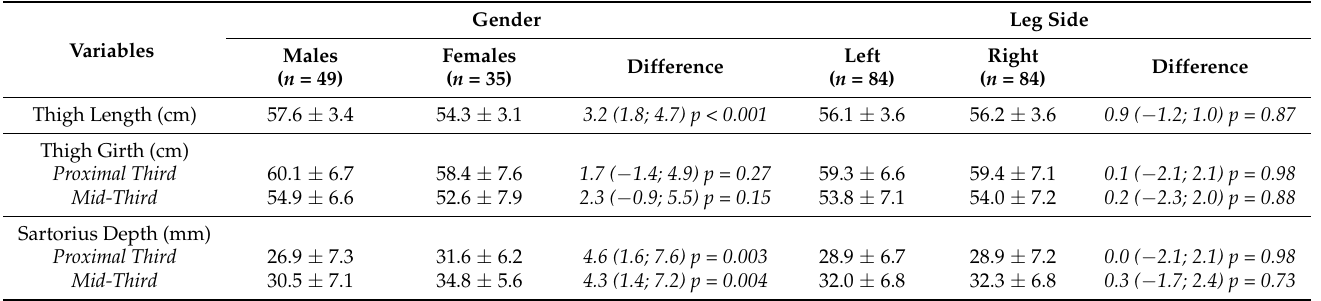
Table 2. Anthropometric and ultrasonographic features by gender and leg